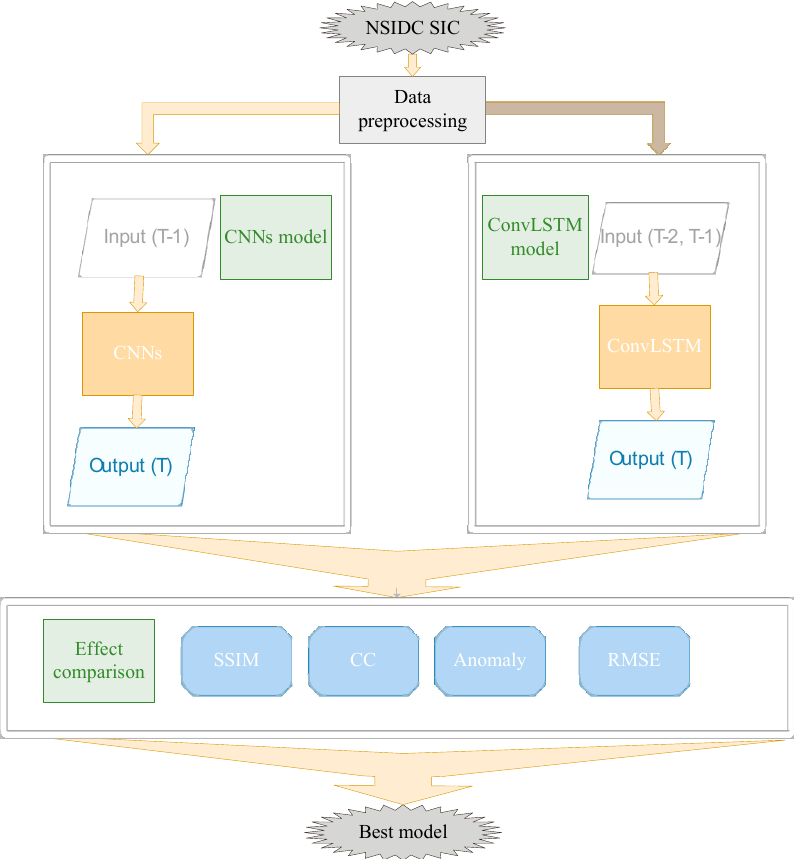
Figure 2. Model construction and comparison. SSIM refers to the structural similarity, and CC refers to the correlation